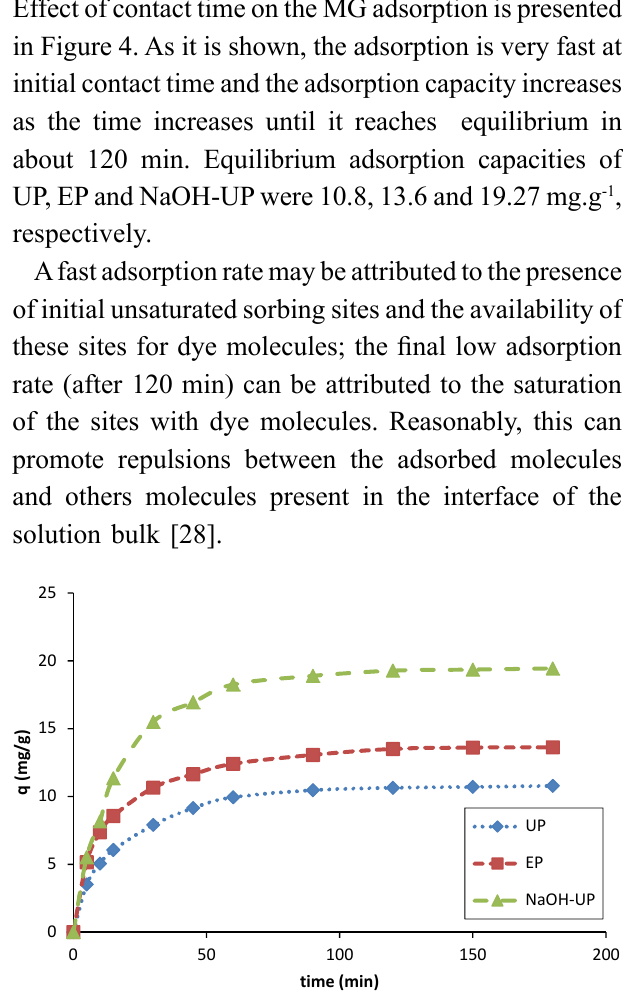
Fig. 4. Effect of contact time on MG adsorption on UP, EP and